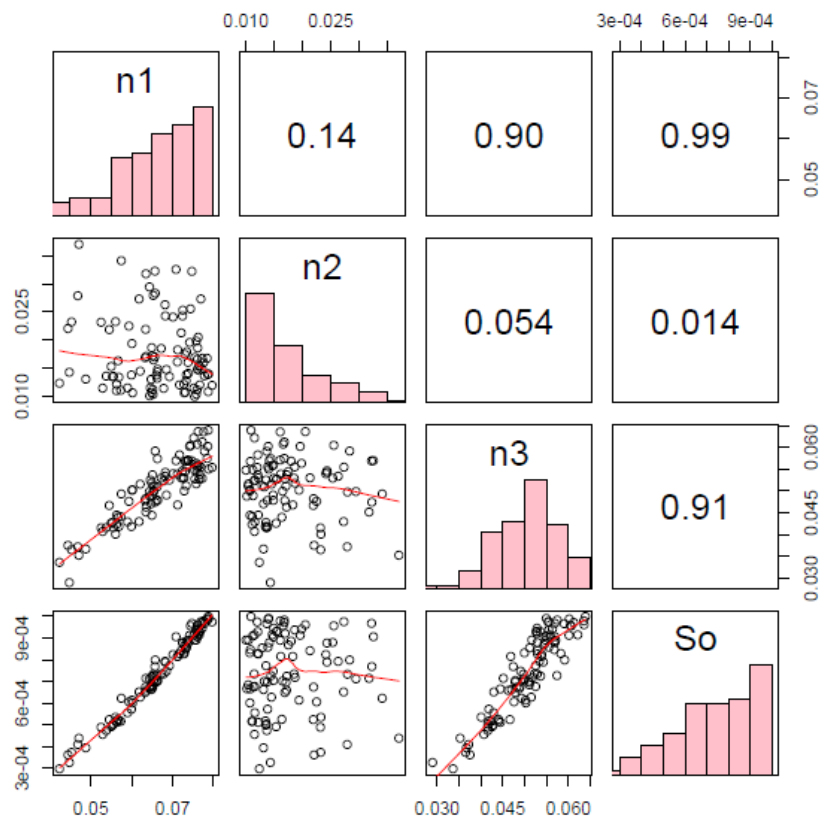
Figure 13. Matrix of graphics relating n 1 , n 2 , n 3 and S 0 —DREAM.